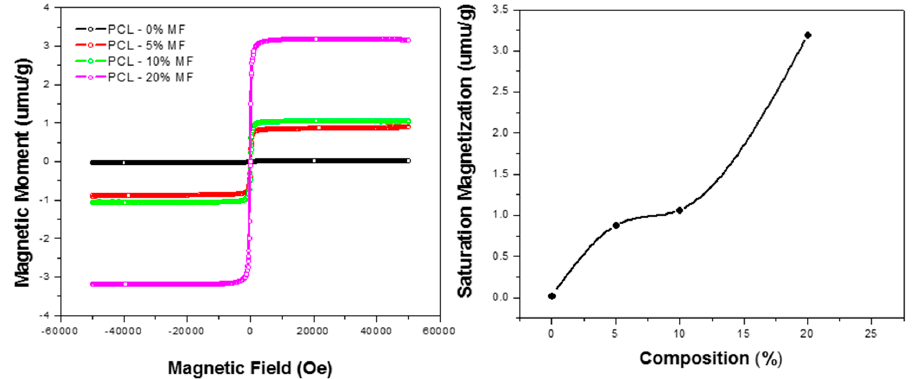
Figure 5. Magnetization curves of Mg-ferrite based PCL/Aloe vera nanofibers.